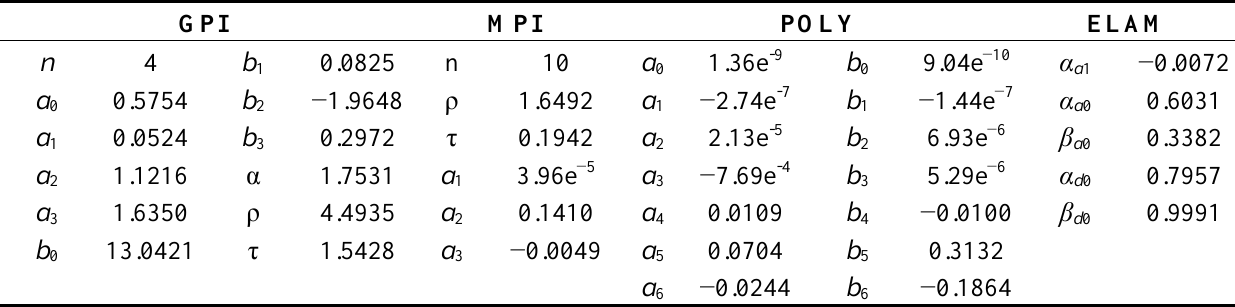
Table 2. Parameters of the models for the descending hysteresis curves of the tactile sensor. GPI MPI